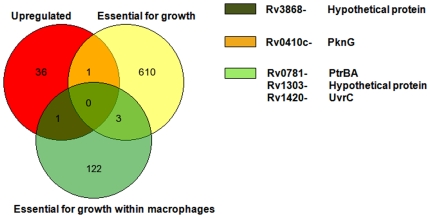
Comparison with Rubin's lists of genes that were found to be upregulated in microarray experiments.Red circle shows the genes upregulated; yellow and green circles show the genes essential for in vitro growth and for survival of mycobacteria within macrophages, respectively.